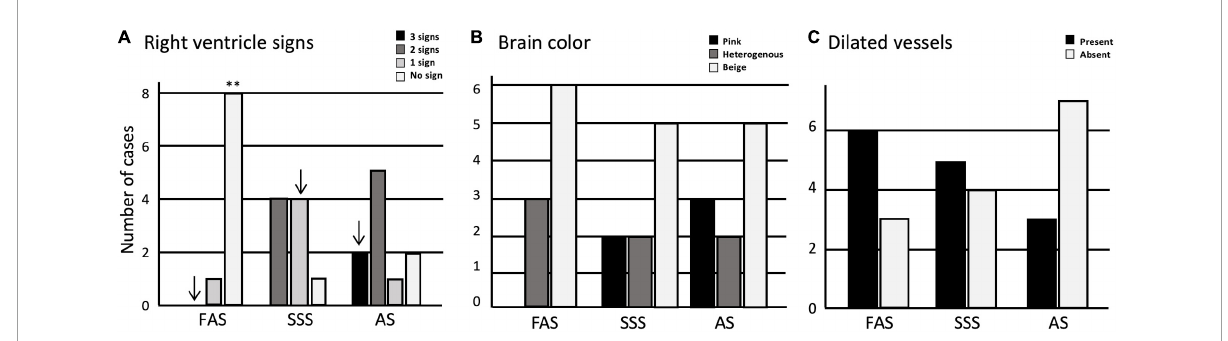
FIGURE2 Bar charts of the perfusion quality. (A) Signs of perfusion in the right ventricle; (B) brain color; (C) presence or absence of dilated vessels. Significance after Bonferroni correction: ∗∗ p < 0.001; ↓ = significant before Bonferroni correction; FAS, formaldehyde solution; SSS, salt-saturated solution; AS, alcohol solution.